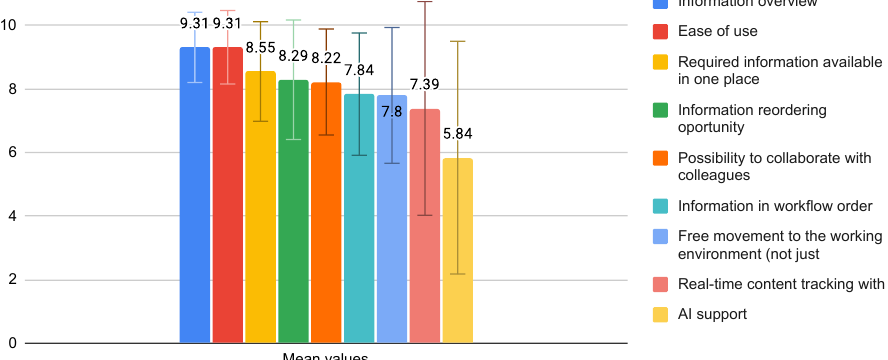
Figure 6. Importance of user